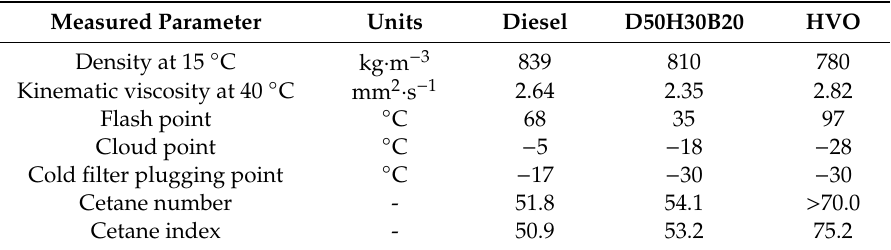
Table 6. Measured parameters of the fuel blends. Measured Parameter